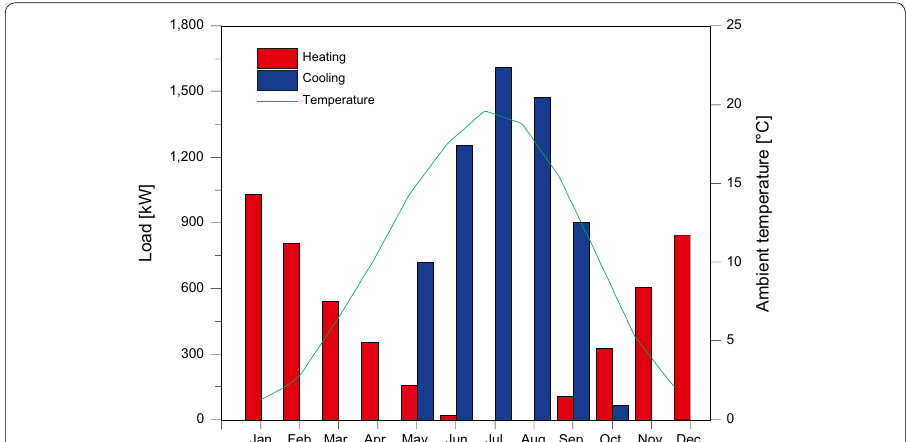
Fig. 2 Annual heating and cooling loads of the building complex and ambient air temperature in Karlsruhe